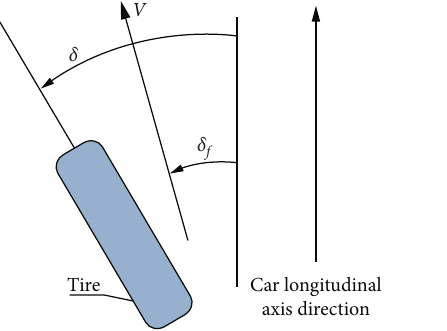
Table 3: Fuzzy control rule